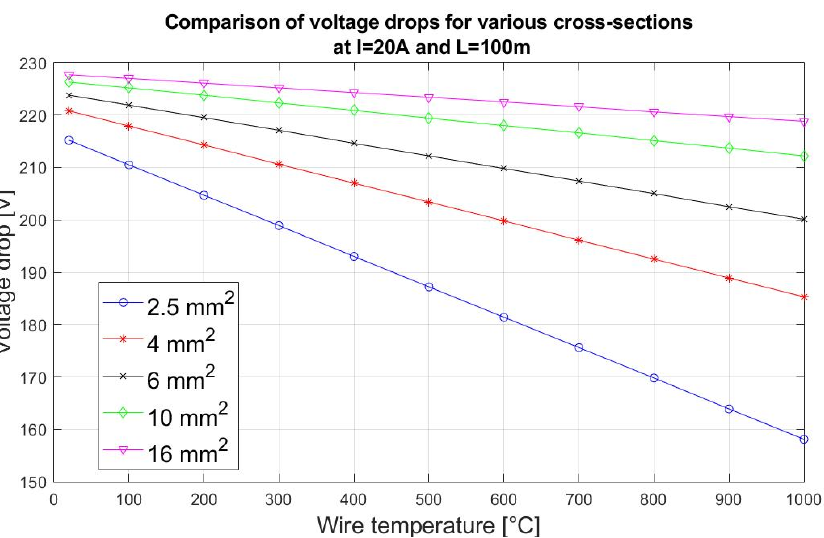
Figure 15. Simulated voltage drops depending on the cable temperature and cross ‐ section.